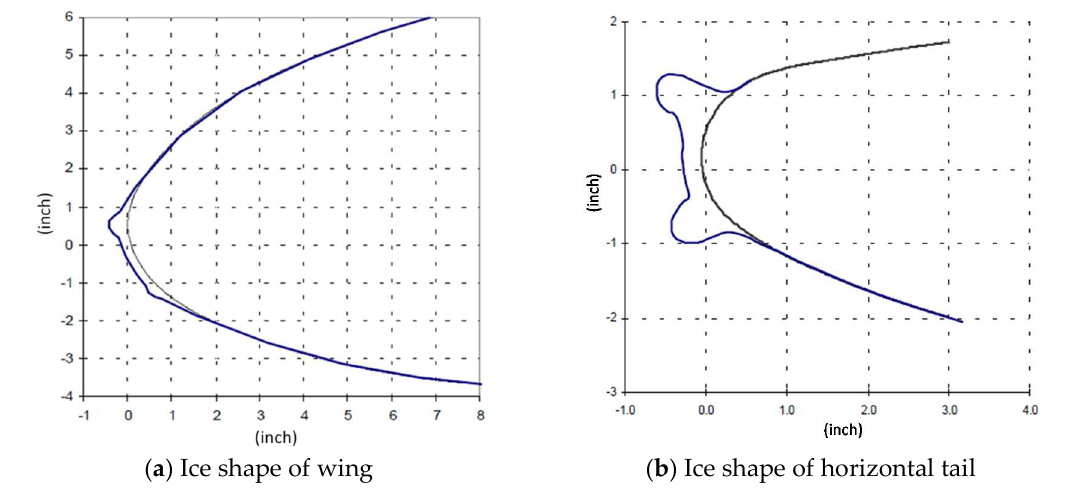
Figure 7. Ice shape of “all iced” aircraft [17].